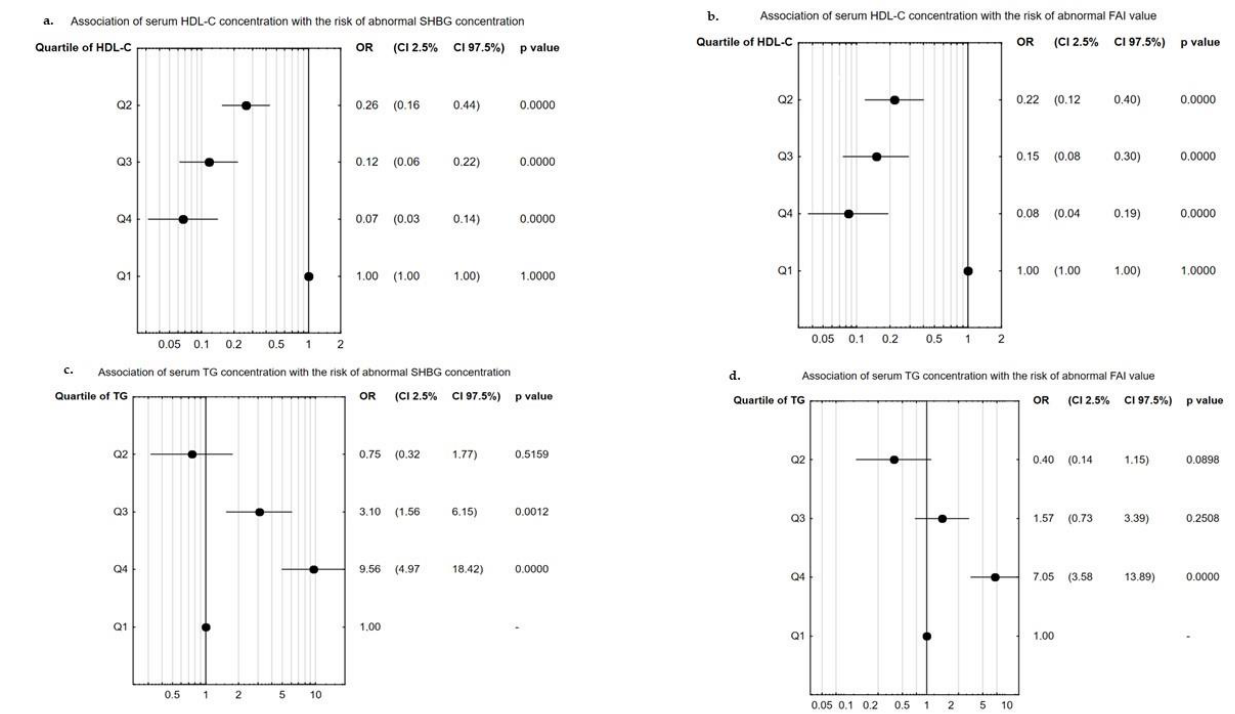
Figure 1. Odds ratio for abnormal serum SHBG concentration or FAI value in quartiles of serum HDL-C or TG level: ( a , c ) association between concentration of SHBG and quartiles of HDL-C or TG level; ( b , d ) association between value of FAI and quartiles of HDL-C or TG level.